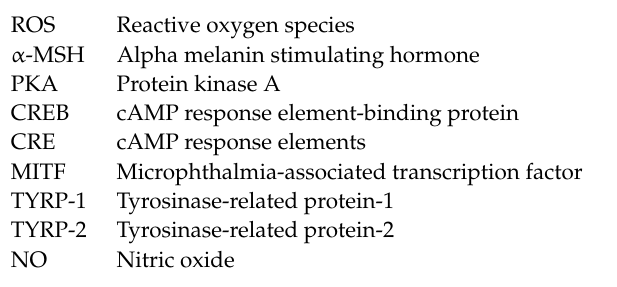
Figure 7. Summary of anti-melanogenic activity of LOs in α -MSH-treated B16F10 cells.